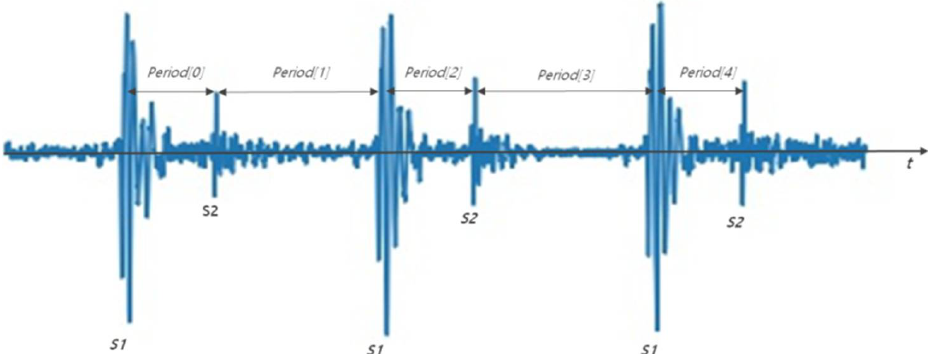
Figure 3. S1 and S2 detection method through time difference. Period [0], Period [2], Period [4] are 250 to 350 ms, and period [1] and period [3] have values between 350 and 800 ms.